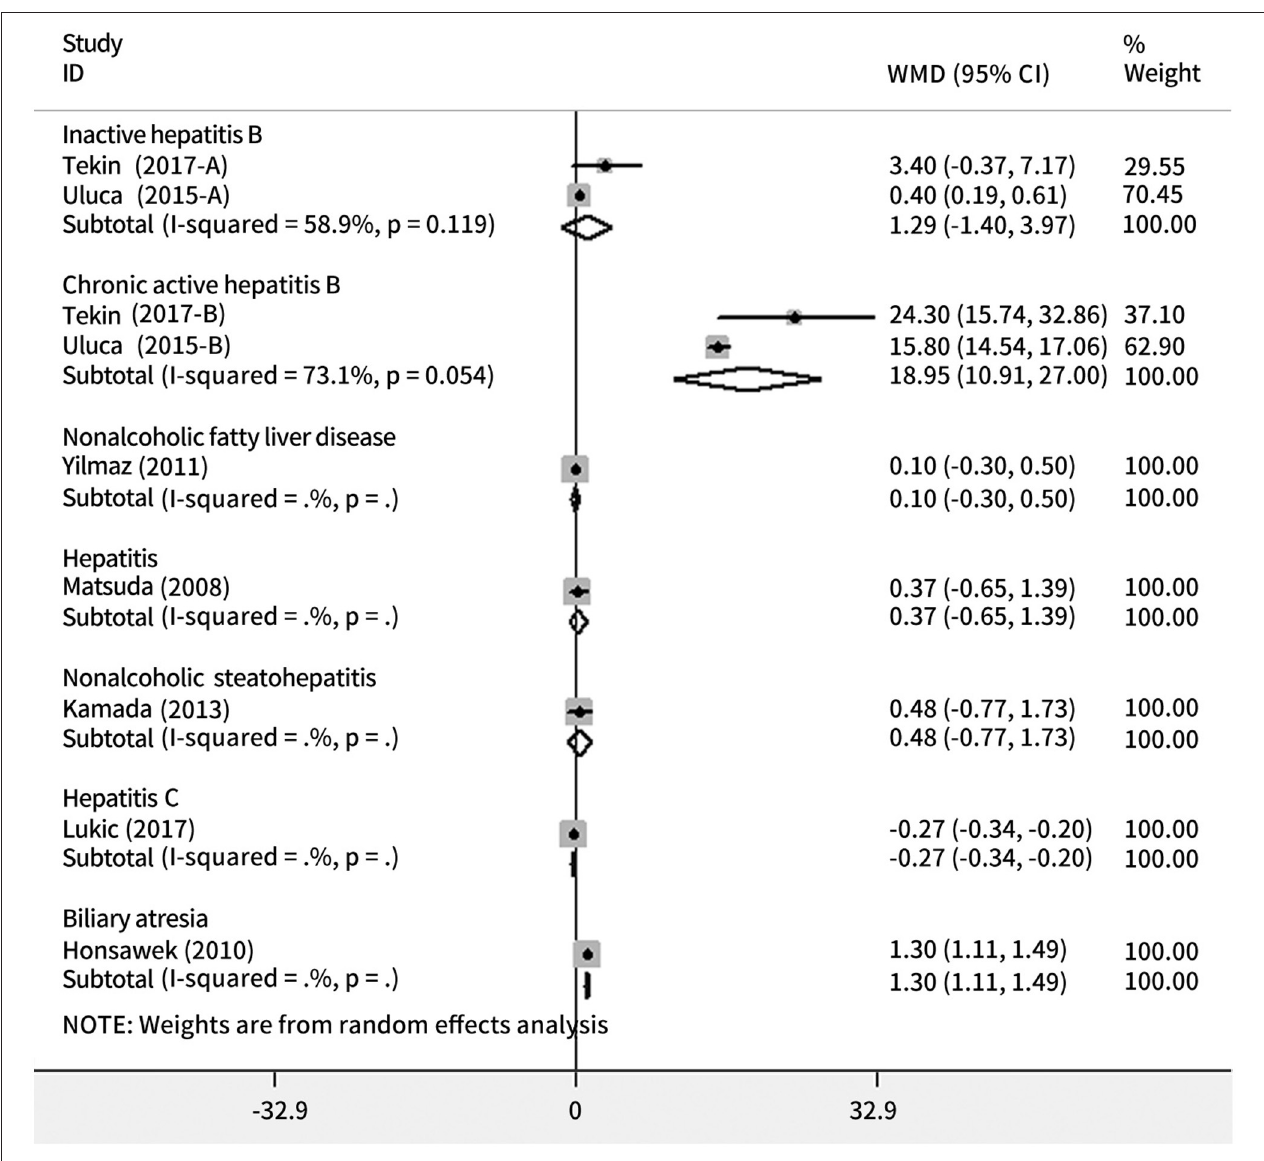
FIGURE 2 | Forest plots showing the association between the risk of chronic liver diseases and